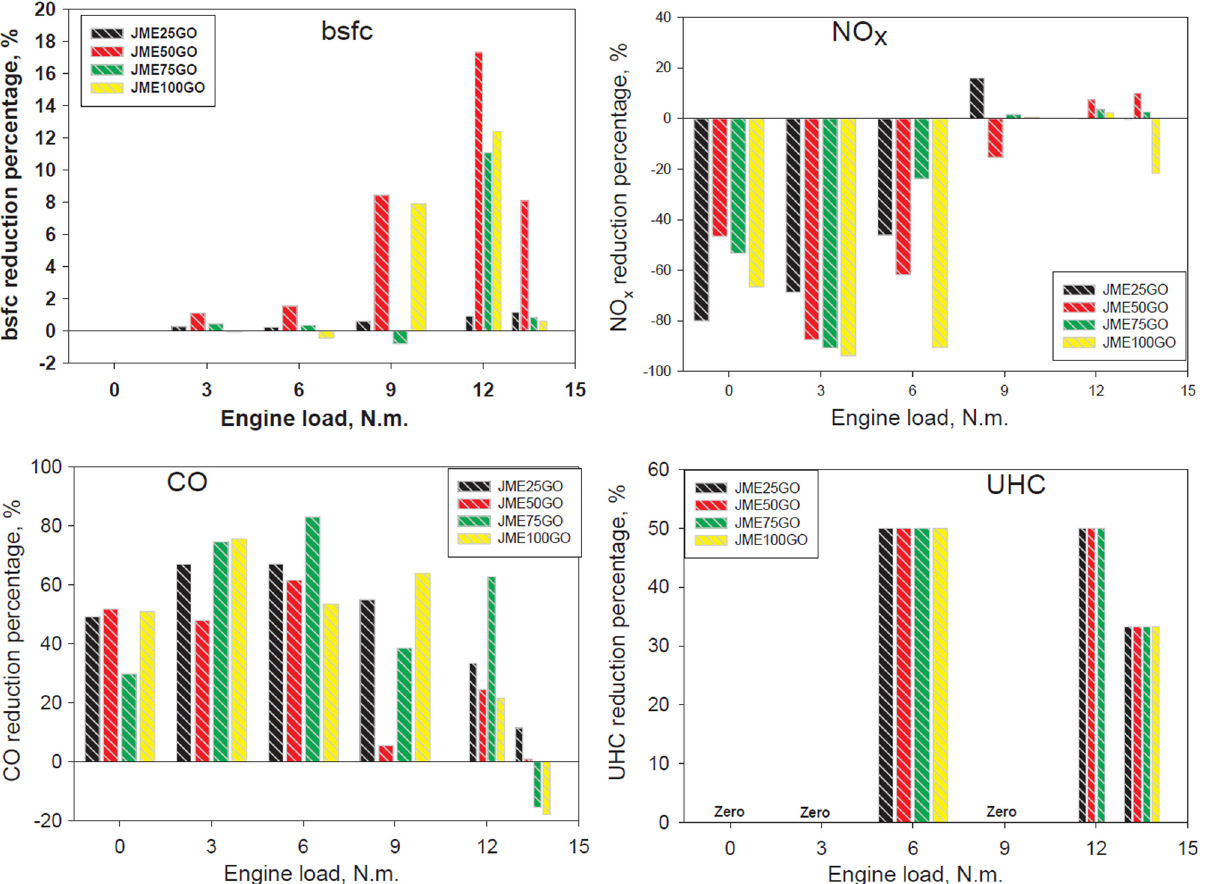
Figure 4: The reduction percentage of the BSFC, NO x , CO, and UHC emissions under di ff erent engine loads [ 143 ]